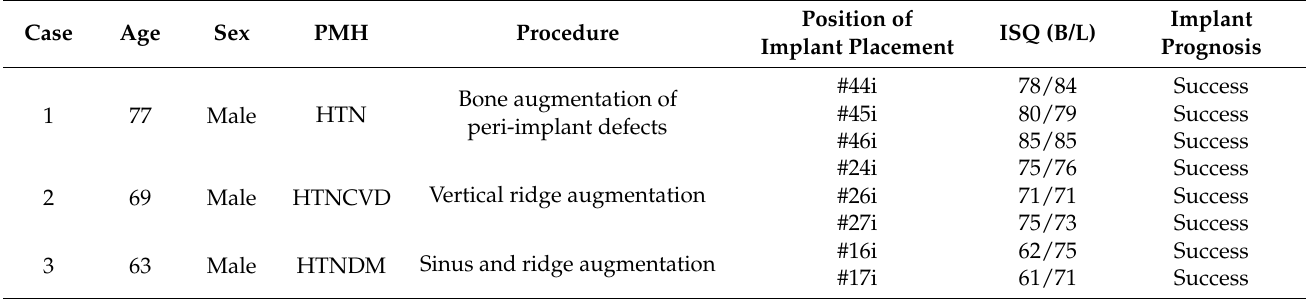
Table 1. Characteristics of the patients.